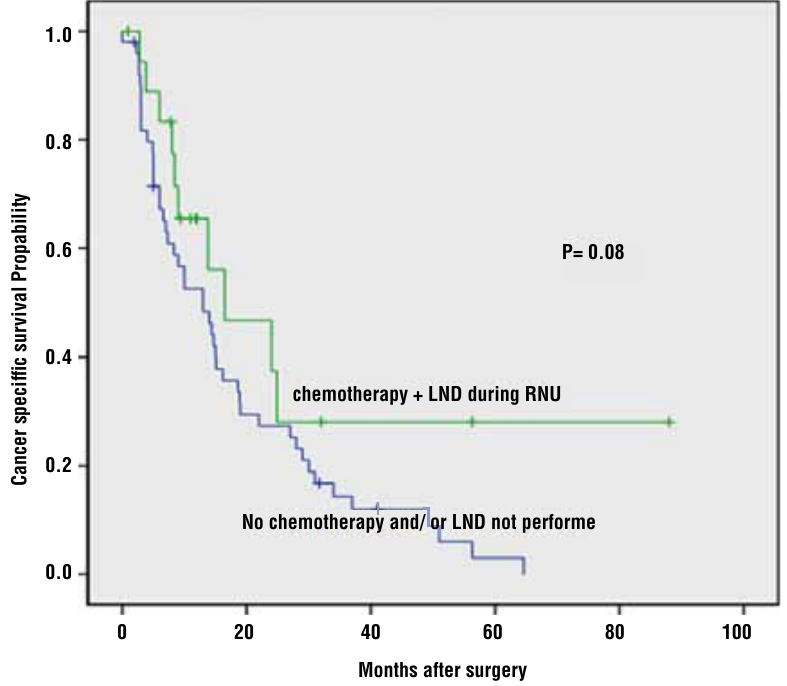
Figure 2 - Cancer specific survival probabilities based on whether peri-operative chemotherapy and LND were included in the management of T4